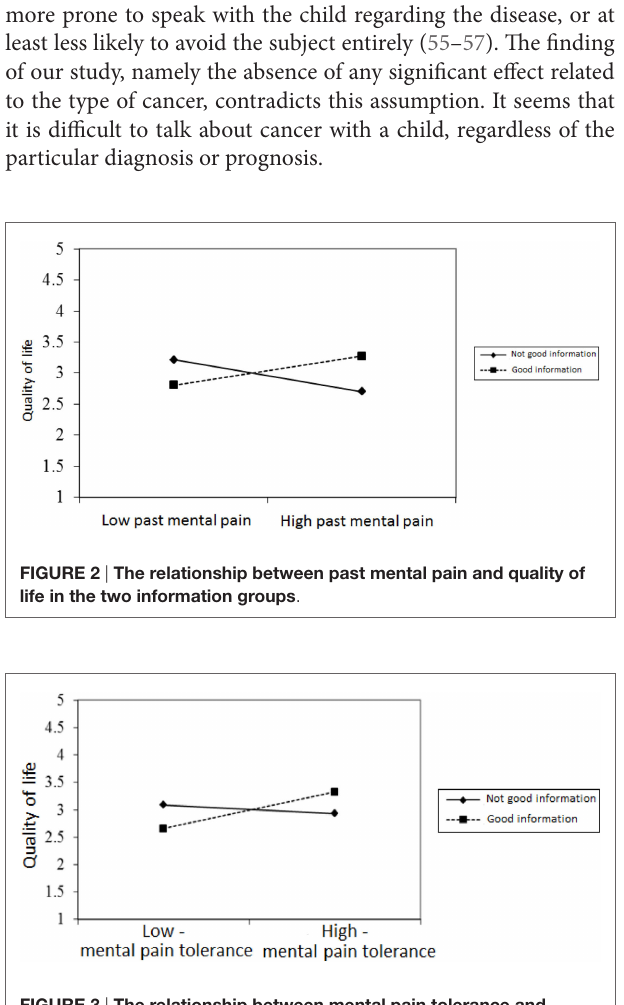
FigUre 3 | The relationship between mental pain tolerance and quality of life in respondents who received good and not good information .